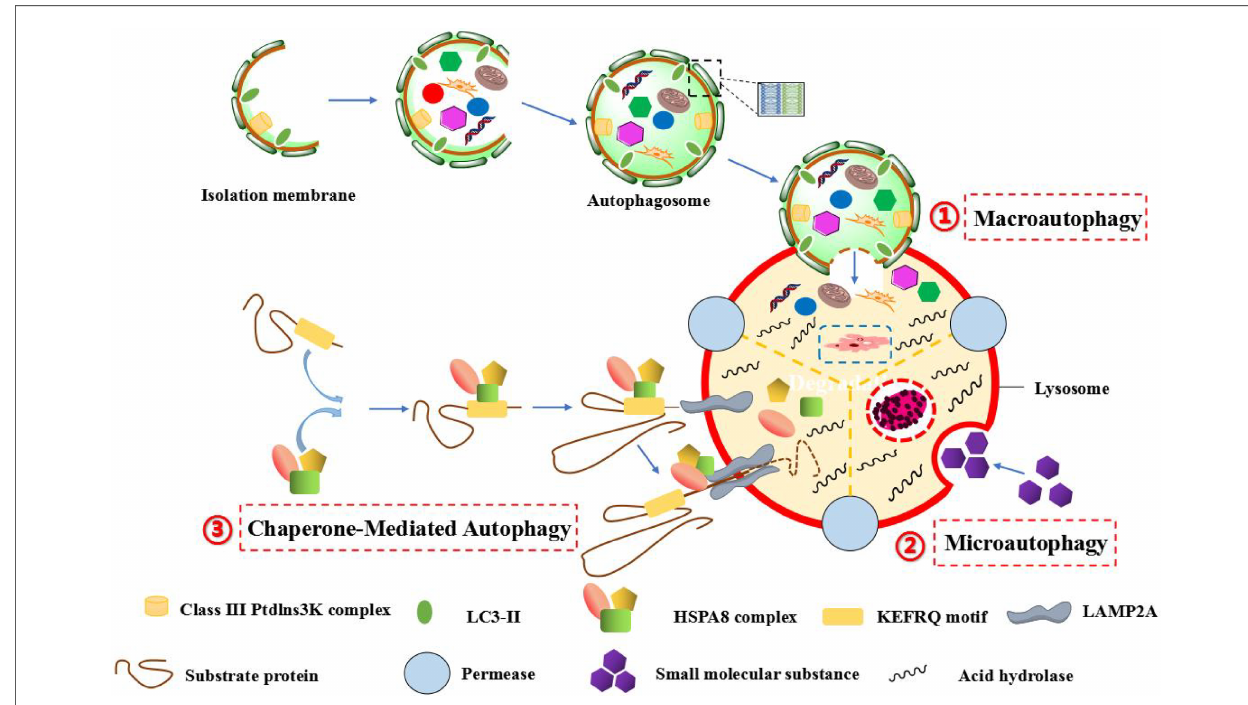
FIGURE 1 The autophagic process of three different forms in mammalians. (1) Macroautophagy, which is characterized by the formation of autophagosomes with a double-layer membrane structure engulfs intracellular macromolecular substances in a wrapped manner, and the autophagosome eventually fuses with lysosome to form autophagic lysosome, and the inclusion bodies are degraded by hydrolytic enzymes in lysosome. (2) Microautophagy, which is characterized by the speci fi c organelles are directly engulfed in an invaginated manner by the deformation of lysosomal or vacuole surface, and the lysosomal membrane inwardly folds to crush the contents. (3) Chaperone-mediated autophagy (CMA), which is characterized by the speci fi c amino acid sequence (such as KEFRQ motif) of soluble protein is identi fi ed and combined by a chaperone-dependent protein (such as HSPA8 complex), and transfer it to lysosomes via the receptor LAMP2A on the lysosomal membrane, so as to allow misfolded proteins to undergo defolding and complete degradation by hydrolytic enzymes in